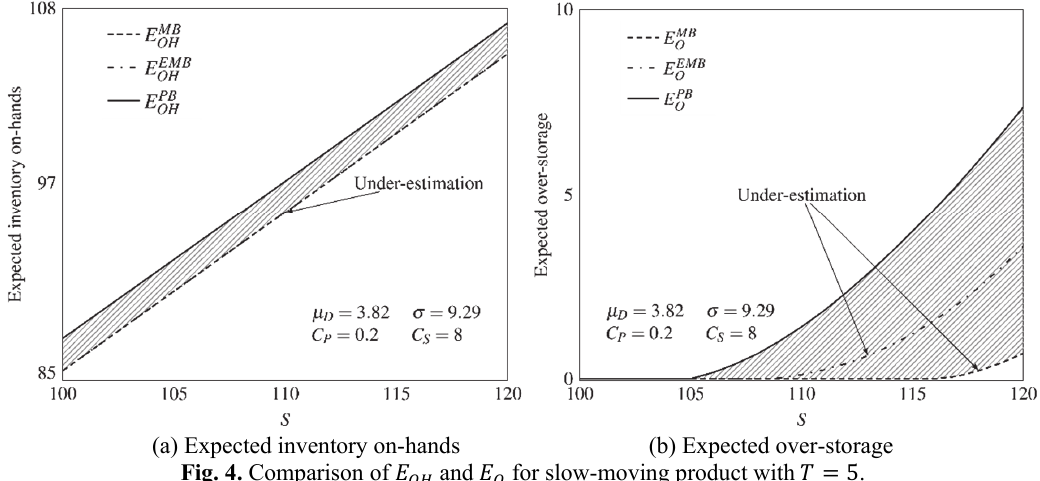
Fig. 4. Comparison of 𝐸